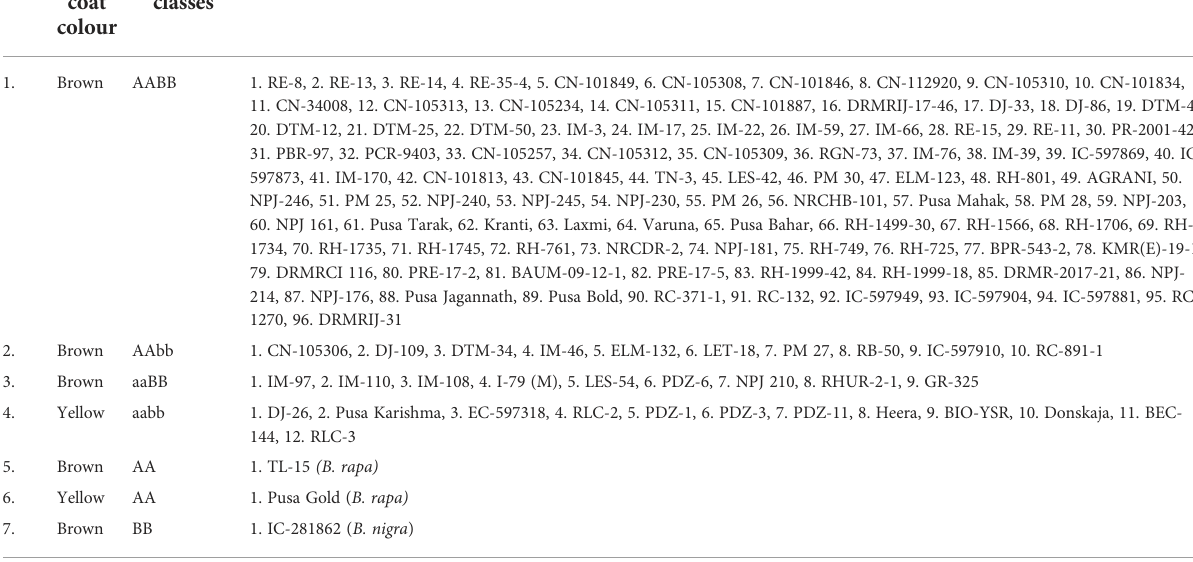
TABLE 3 Classi fi cation of mustard genotypes based on seed coat colour and their genotypic classes using Bju.ATT8 (AA/aa) and Bju.BTT8 (BB/bb) markers. S.N.